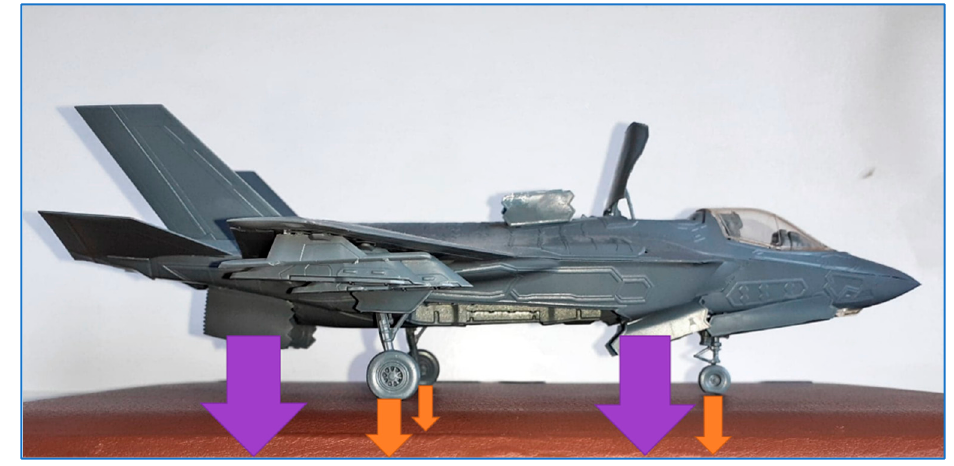
Figure 5. Locations of the pressures applied to the deck during a vertical landing. Uniformly distributed loading (UDL) was modelled across one section of the deck plating as a line pressure (no wheels deployed). The models were designed with one and two stiffeners to position the highest load on the plate, and then on the stiffeners. For the empirical calculations, the section of plate was modelled as a simply supported beam, with fixed supports at either end. FEA mesh element size was 0.03 m. The UDL condition was split into two